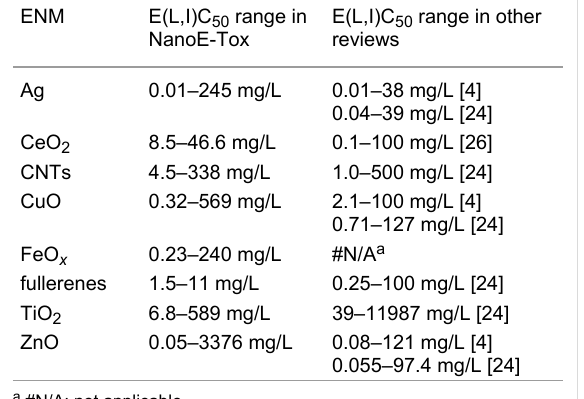
Table 2: Comparison of the median E(L,I)C 50 values for different species in NanoE-Tox database and previous reviews